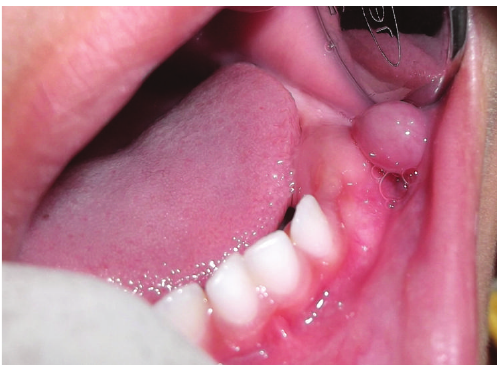
Figure 1: Clinical presentation of the lesion.